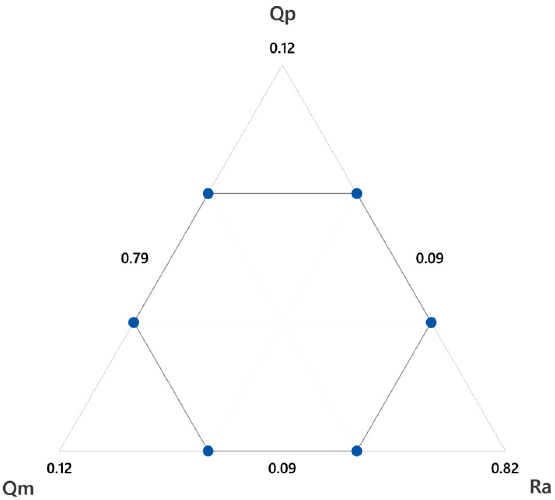
Figure 5. Optimization runs performed for the sensibility analysis in the finish step, with a 1% variation of the importance.